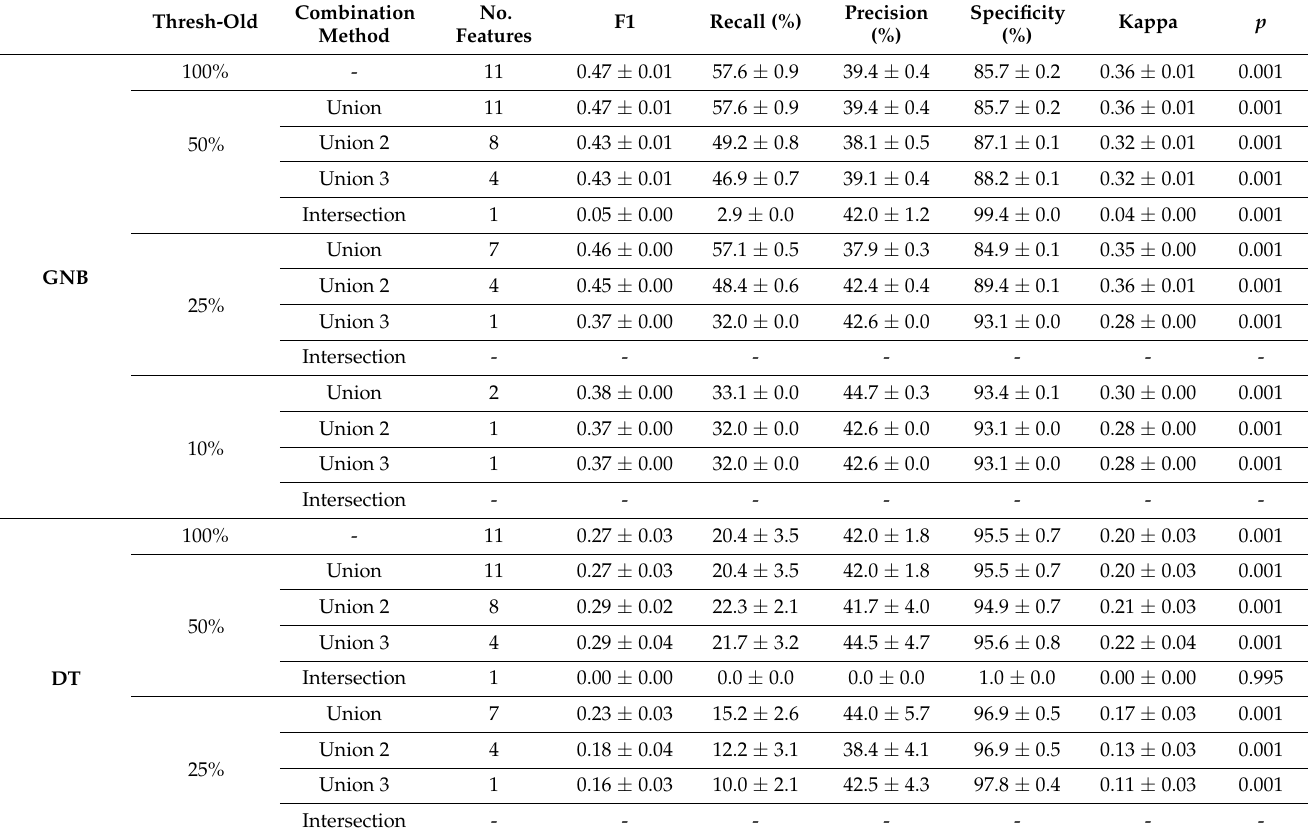
Table A3. Performance of the four classification models on detection fall using Basic data set ; basic data set exists of the 25 Foot Walk Test + 2-minute walk test + Expanded Disability Status Scale; Gaussian Naive Bayes (GNB); Decision Tree (DT); k-Nearest Neighbor (kNN); Support Vector Machine (SVM); p -value via permutation